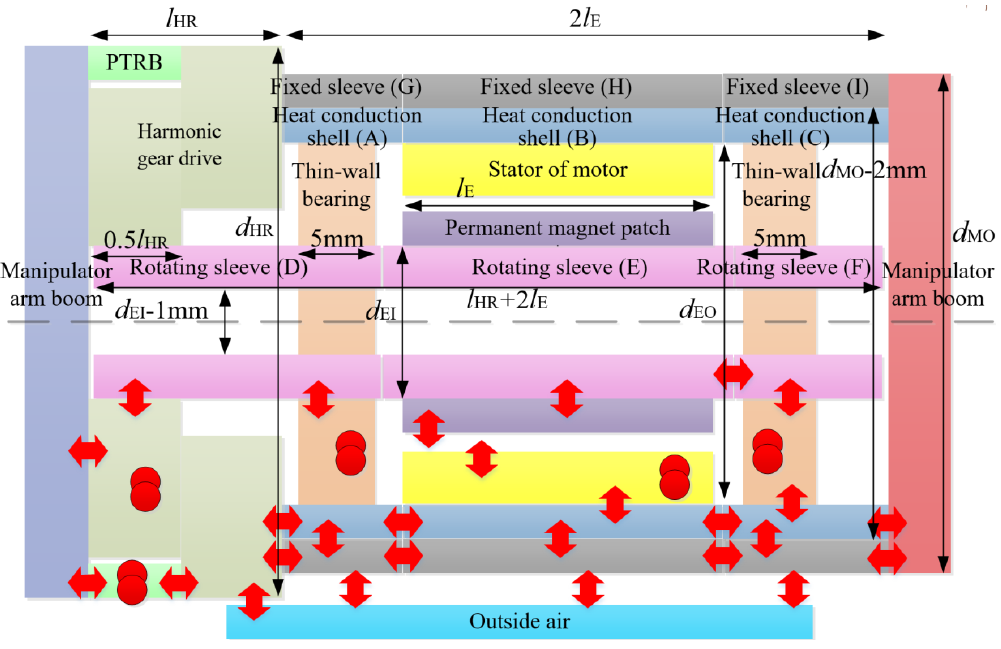
Figure 6. Heat transfer path of GIERM Scheme 1.